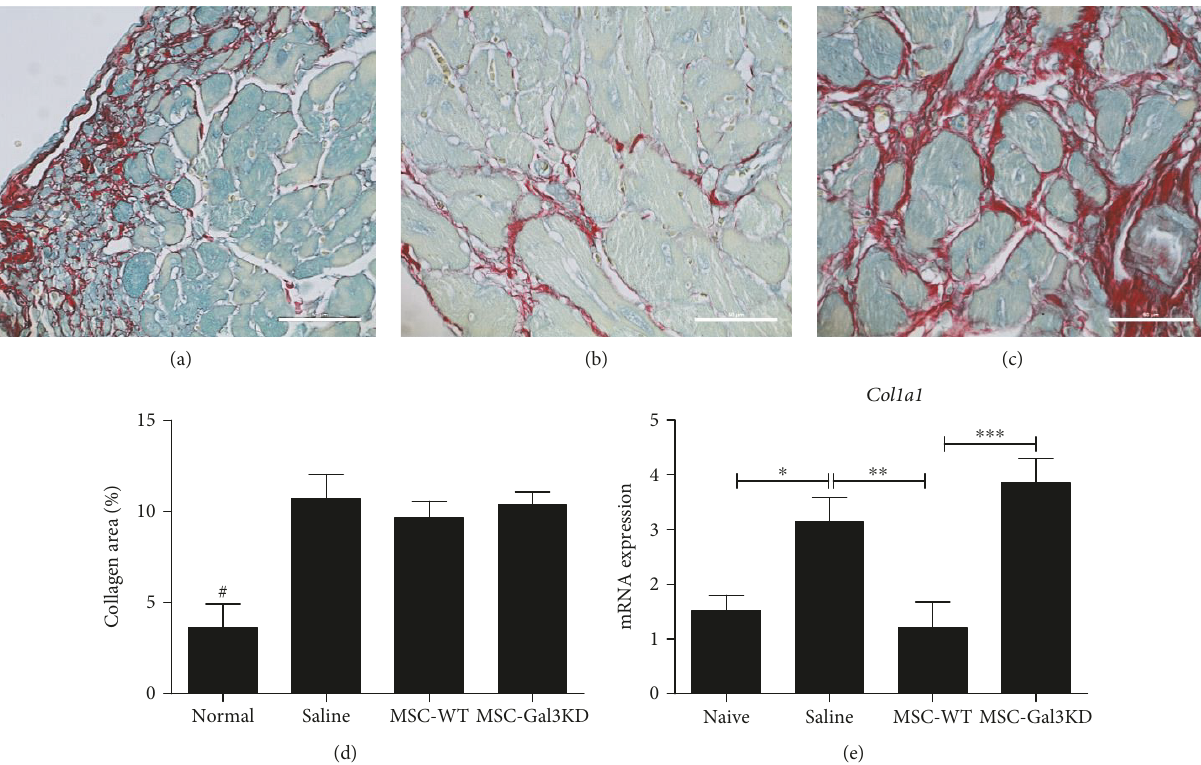
Figure 6: Modulation of collagen synthesis in the heart after administration of MSC. Representative images of Sirius red stained heart sections of T. cruzi infected mice administered with saline (a), MSC-WT (b), or MSC-Gal3KD (c). (d) Quanti fi cation of the collagen- stained area by morphometry. (e) Type I collagen ( Col1a1 ) gene expression analysis by qRT-PCR in the heart tissue. ∗ P < 0 05 ; ∗∗ P < 0 01 ; ∗∗∗ P < 0 001 ; # P = 0 01 , compared to the other groups.